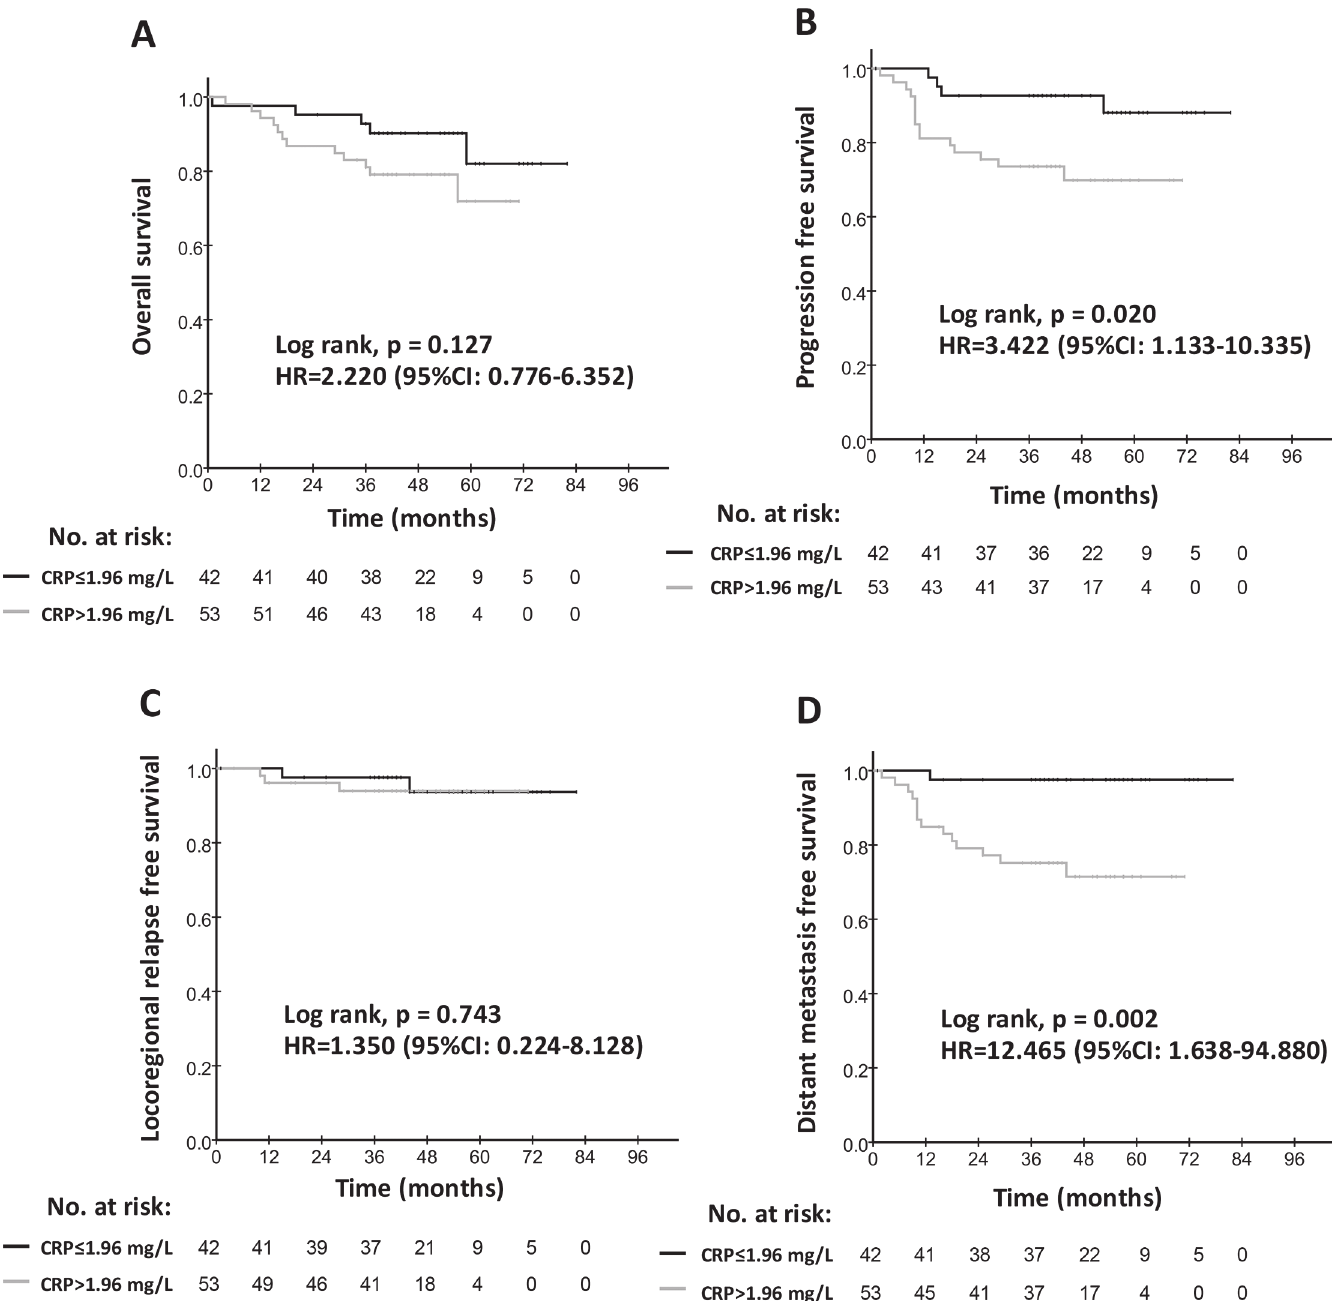
Fig 4. Kaplan-Meier survival curves for the low hs-CRP group ( (cid:3) 1.96 mg/L) and the high hs-CRP group ( > 1.96 mg/L) in patients with cardiovascular disease. Overall survival rates (A), progression-free survival rates (B), locoregional relapse-free survival (C) and distant metastasis-free survival rates (D) were compared in the subgroup of NPC patients with cardiovascular disease. Hazards ratios (HRs) were calculated using the unadjusted Cox proportional hazards model. P values were calculated using the unadjusted log-rank